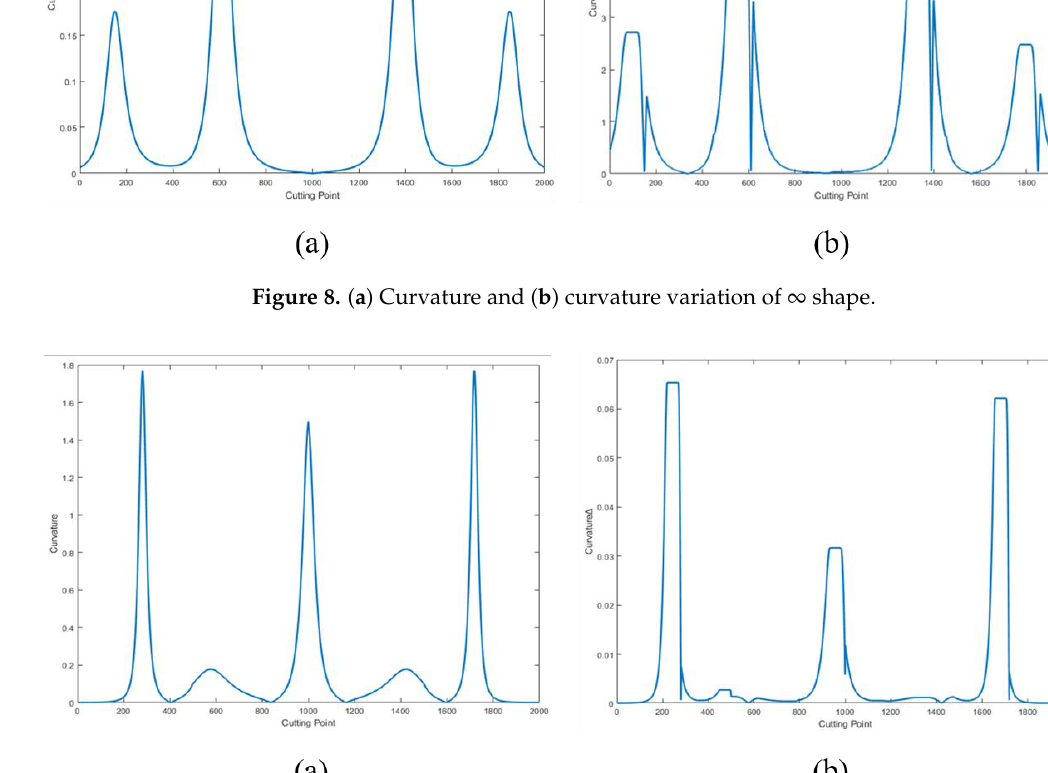
Figure 10. ( a ) Curvature and ( b ) curvature variation of butterfly shape. To ensure all the shapes are engraved with the same depth, each aluminum 6061 alloy workpiece will be face-processed before cutting. Furthermore, to prevent the tool from bending, the depth of cut is set to 2 mm. Figure 11a shows the cutting process of an aluminum workpiece, and Figure 11b shows the aluminum workpiece after cutting. Figure 11. ( a ) Cutting of aluminum workpiece and ( b ) aluminum workpiece after cutting.